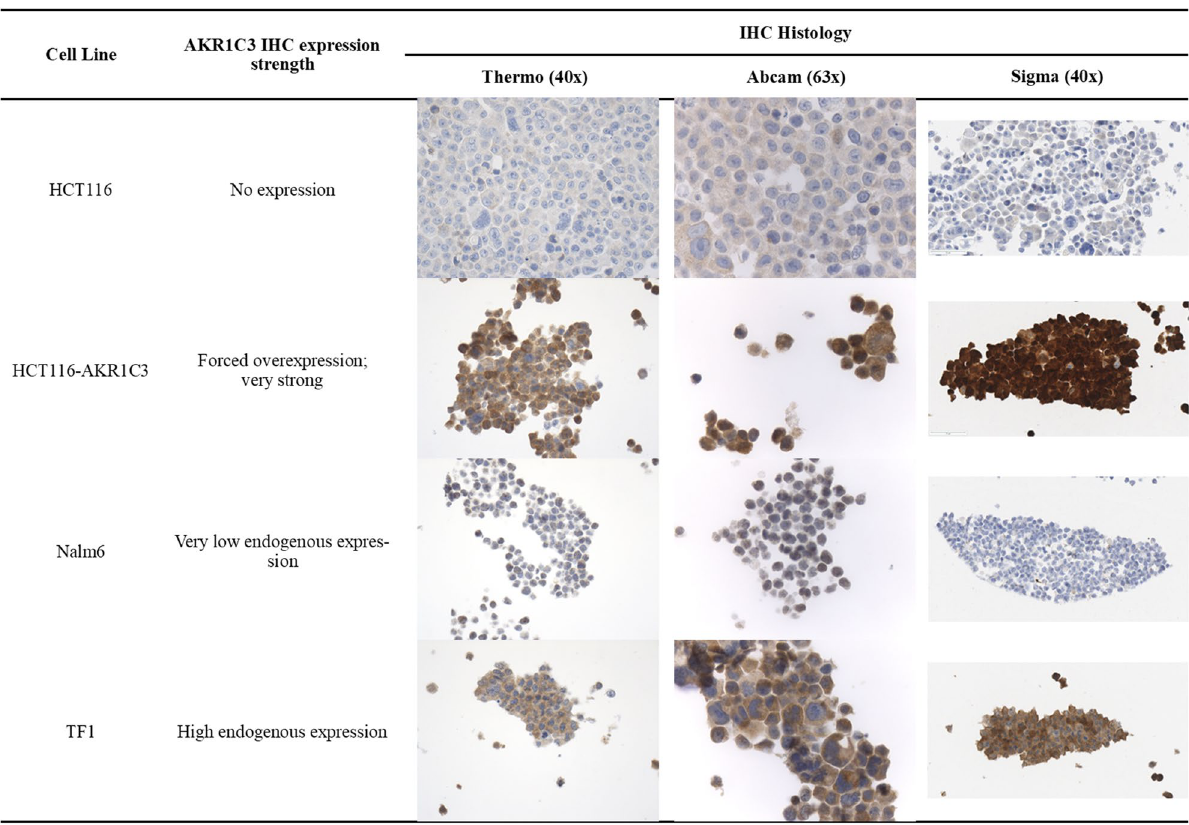
Figure 1. AKR1C3 immunoreactivity of four antibodies on control cell lines. Immunoreactivity of Thermo Fisher Scientific (Clone#PA5-23667), rabbit monoclonal Abcam [EPR16726] (ab209899) and Sigma/Millipore Anti-AKR1C3 antibody, mouse monoclonal, clone NP6.G6.A6, on different control cell lines. HCT116 is a human colorectal cancer cell line. HCT116-AKR1C3 is HCT116 engineered overexpress AKR1C3. Nalm6 is a Pre-B cell ALL cell line with very low endogenous AKR1C3 expression. TF1 is an erythroleukemia cell line with high endogenous AKR1C3